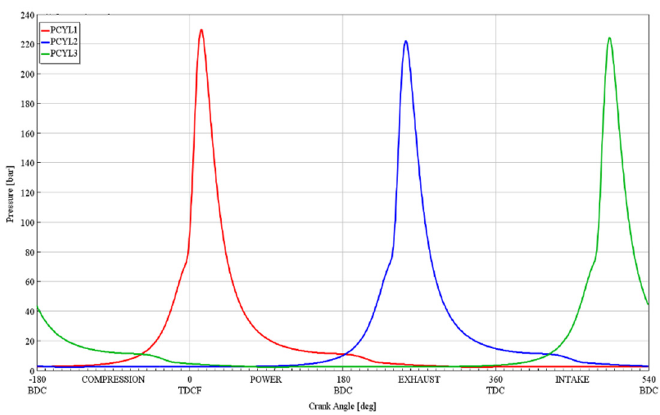
Figure 10. In-cylinder pressure trace simulation result (2500 rpm).